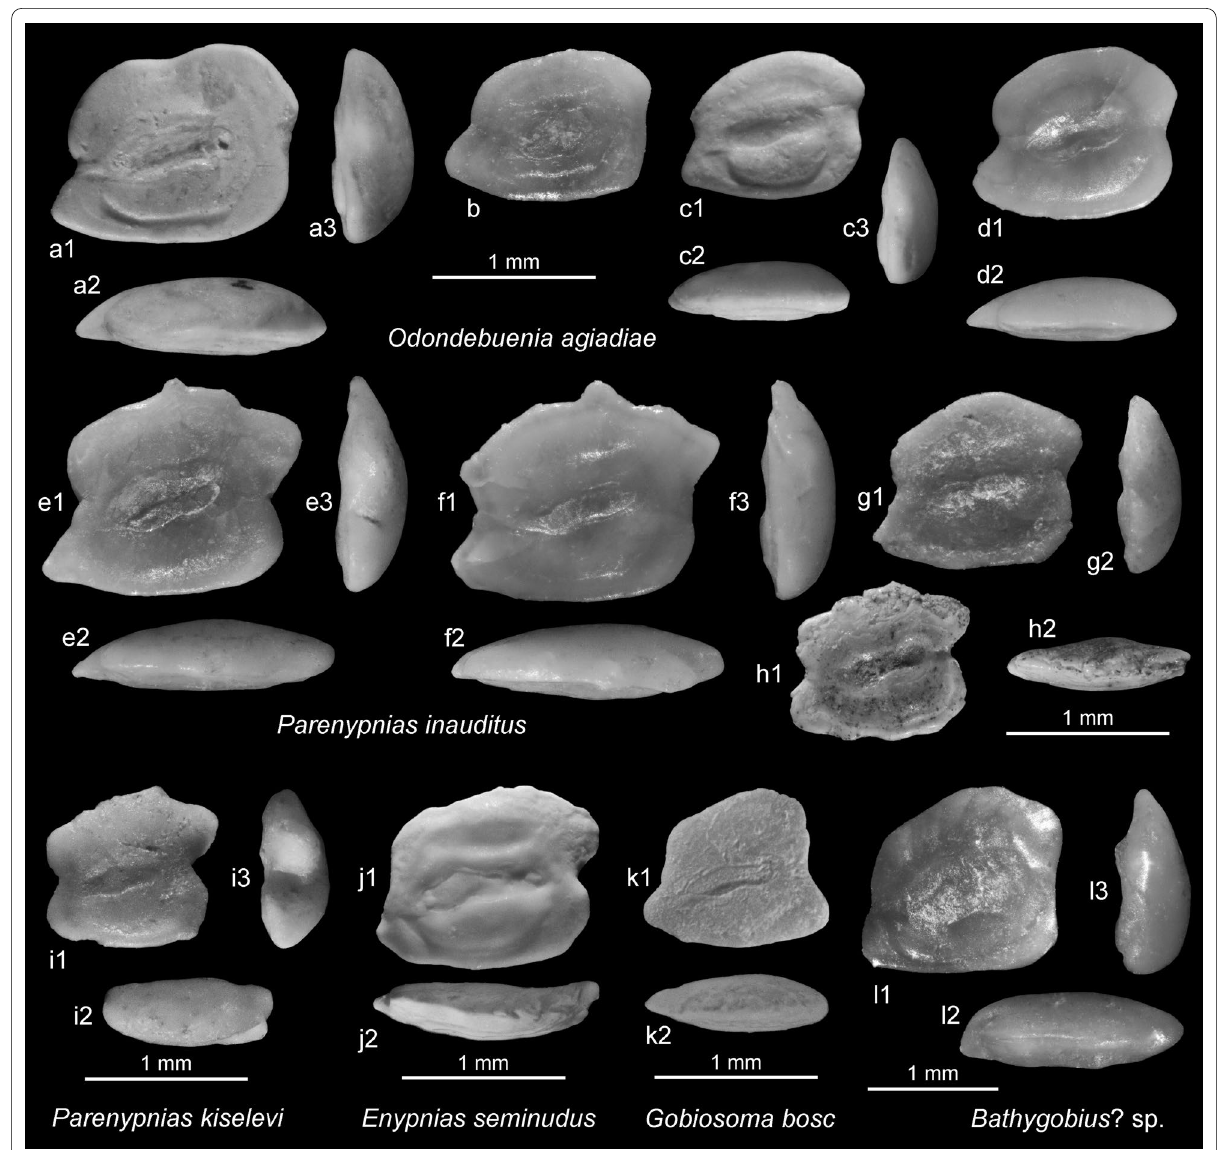
Fig. 5 Otoliths of Odondebuenia, Parenypnias and Bathygobius ?: a – d Odondebuenia agiadiae Schwarzhans et al., 2020a, 2020b, a (reversed) Kozatskyi Yar, NMB P1219, b (reversed), d Kozatskyi Yar, NMNHU-P PI 2569, c (reversed) Mlyntsi, NMNHU-P PI 2570. e – h Parenypnias inauditus n. gen. et n. sp., f holotype, Kozatskyi Yar, NMNHU-P PI 2550, e , g (reversed) Shydlivshchyna, NMB P1207, h Žižkov 1 well (1616–1622 m), DGS MU-0395. i Parenypnias kiselevi n. gen. et n. sp., holotype, Mlyntsi, NMNHU-P PI 2574. j Enypnias seminudus (Günther, 1861), Recent, USNM 407784, 13° 22 ′ N 87° 52 ′ W. k Gobiosoma bosc (Lacépède, 1800), Recent (reversed), LACM coll. Fitch, off Rappahannock. l Bathygobius ? sp. (reversed), Kozatskyi Yar, NMNHU-P PI